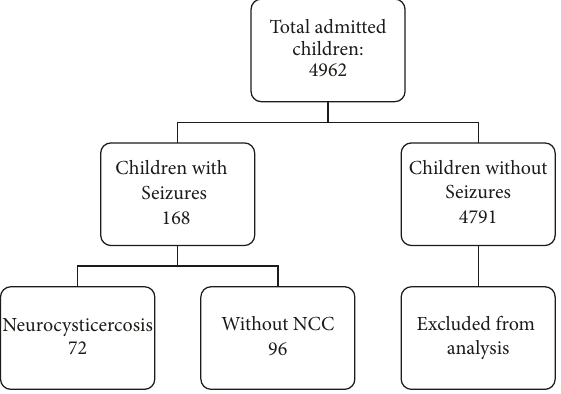
Figure 1: Flowchart showing work plan of admitted